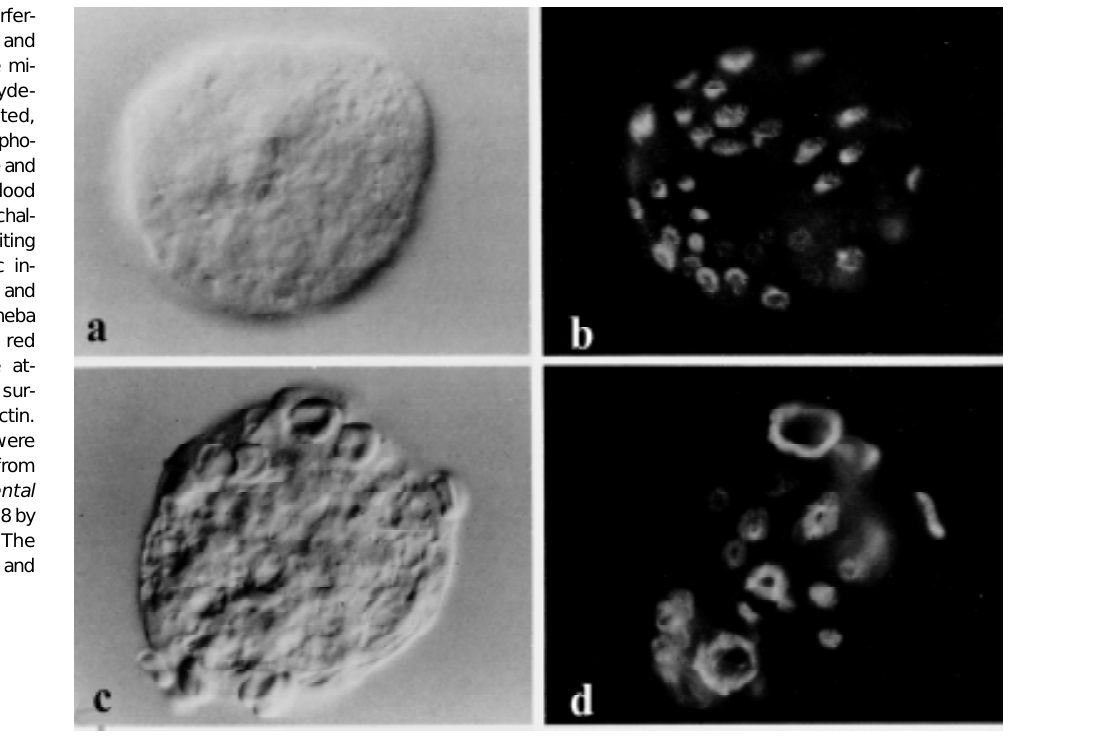
Figure 2 - Differential